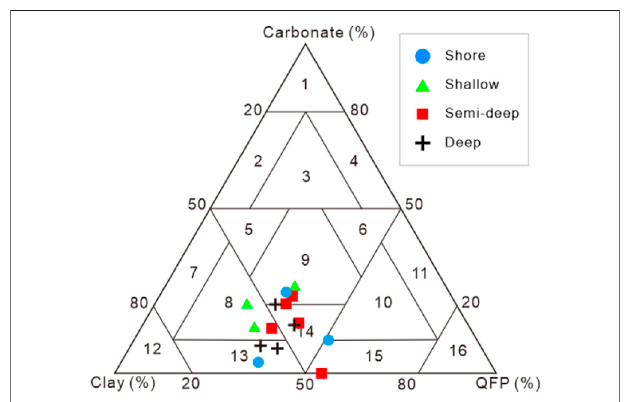
FIGURE 5 | The ternary diagram of the shale lithofacies in the Dongyuemiao member. 1-Carbonate-dominated lithotype; 2-clay-rich carbonate mudstone; 3-mixed carbonate mudstone; 4-silica-rich carbonate mudstone; 5-argillaceous/carbonate mudstone (marl); 6-carbonate/ siliceous mudstone; 7-carbonate-rich argillaceous mudstone; 8-mixed argillaceous mudstone; 9-mixed mudstone; 10-mixed siliceous mudstone; 11-carbonate-rich siliceous mudstone; 12-clay-dominated lithotype; 13- silica-rich argillaceous mudstone; 14-argillaceous/siliceous mudstone; 15- clay-rich siliceous mudstone; 16-silica-dominated lithotype.